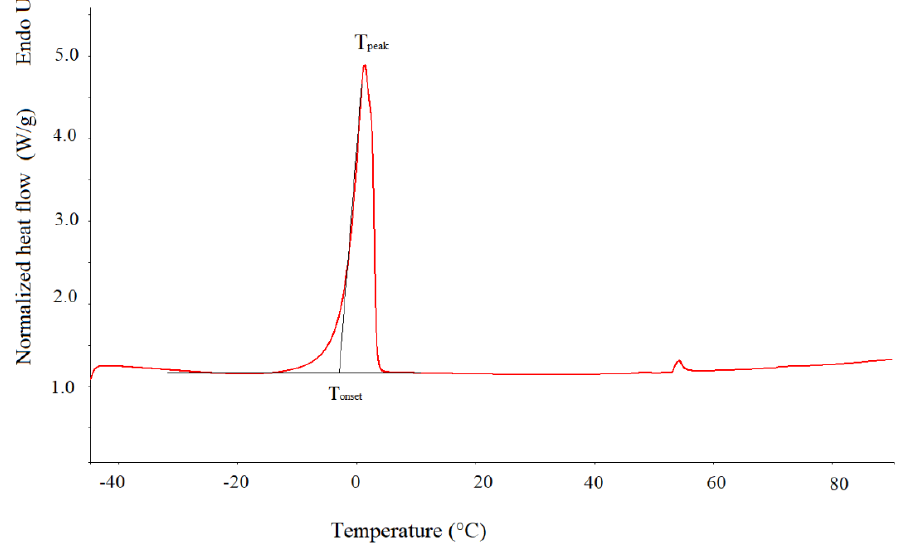
Figure 1. DSC melting curve of BMC cheese sample showing ice melting peak. T onset : onset temperature; T peak : temperature at maximum heat flow value. Table 1. DSC parameters of buttermilk cheese with polymerized whey protein. Parameters